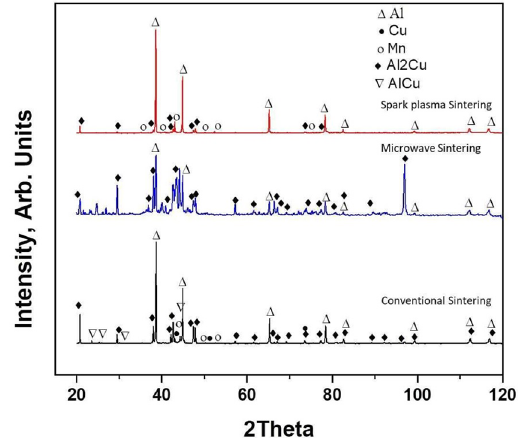
Figure 5. XRD curves of Al -20Cu-15Mn compact (a) Conventional; (b) Microwave; (c) Spark